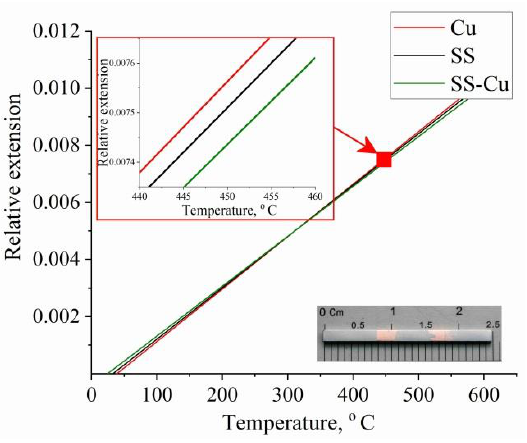
Figure 16. Measurement result of the thermal linear expansion coefficient. Typical result for stainless steel (black curves) and copper (red curves). Solid curves are the result for the bimetallic layered macrocomposite sample.